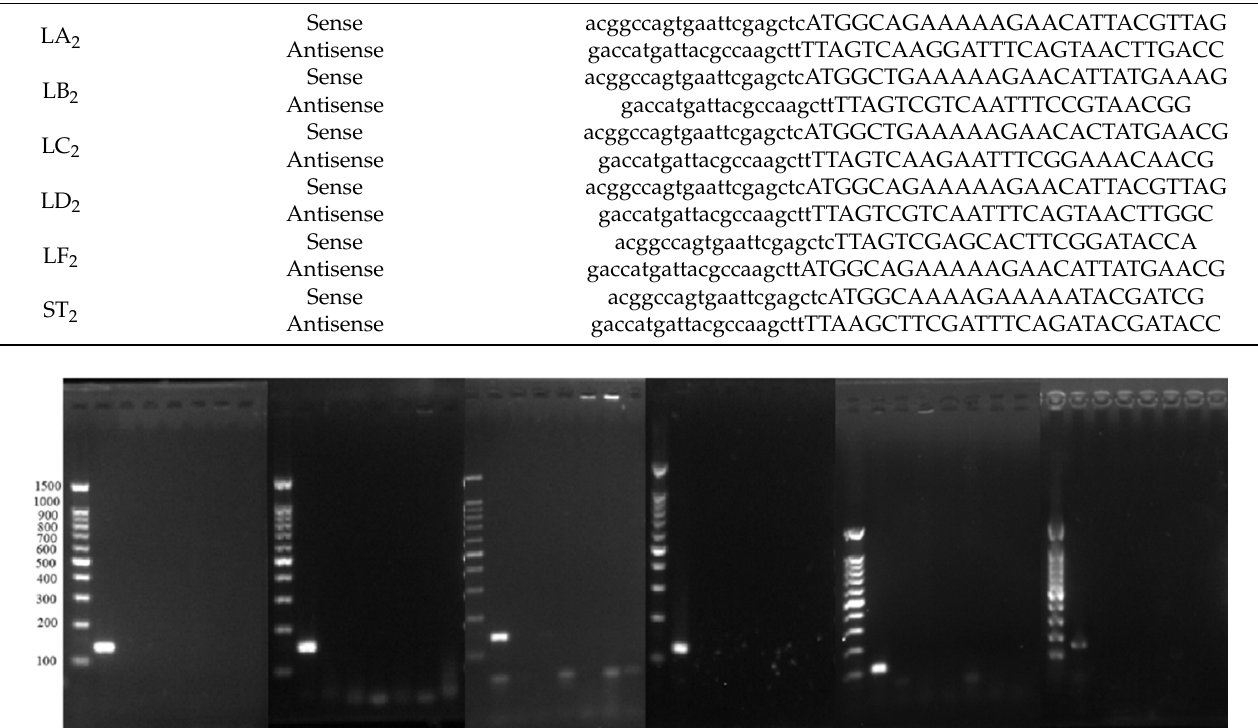
Table 5. Specific primers for six strains of lactic acid bacteria (LAB).